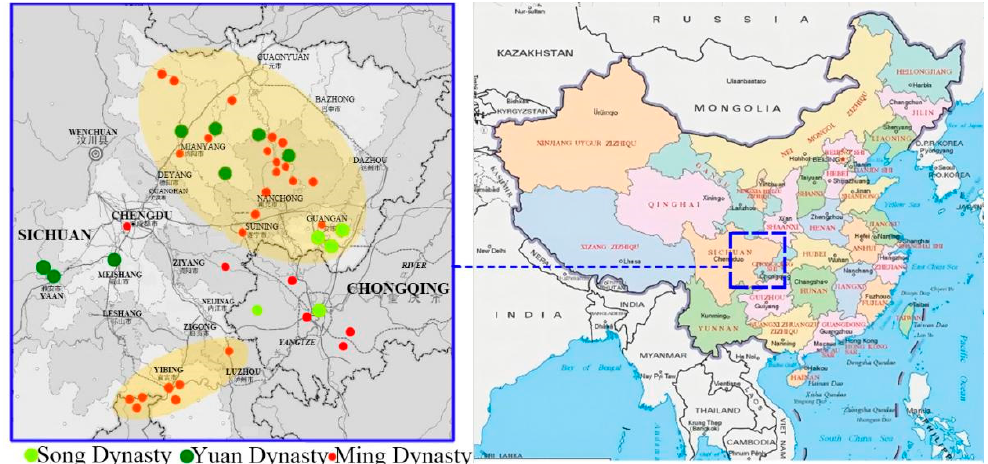
Figure 2. Distribution of Xiegong buildings in the Song, Yuan, and Ming Dynasties in Chongqing and Sichuan [15].